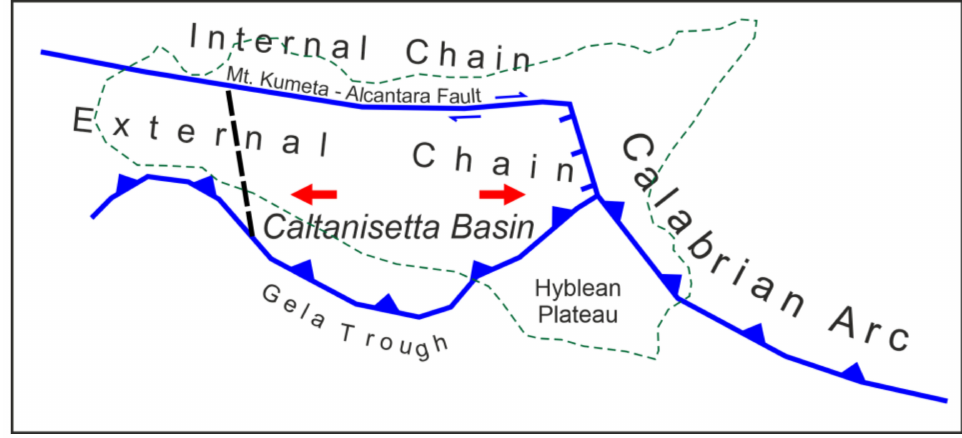
Figure 25. Schematic tectonic evolution of the Caltanissetta Basin. ( Red arrows ) show the direction of